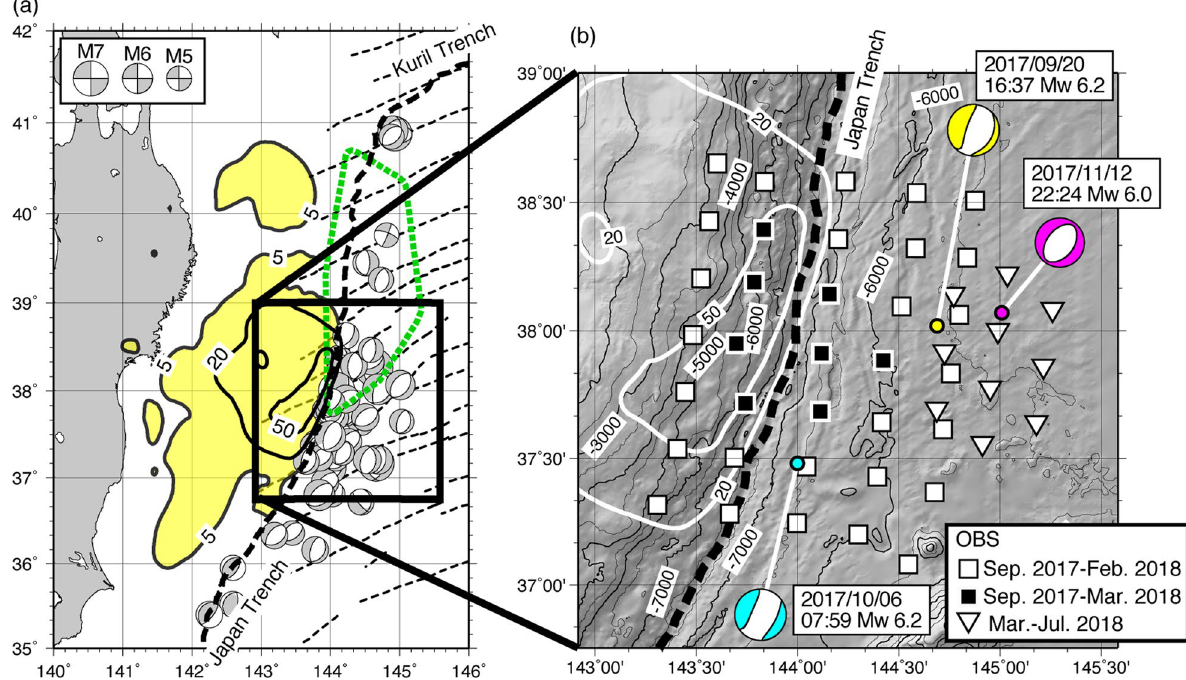
Fig. 1 Map of the survey area in the trench and outer trench slope of the central Japan Trench. a GCMT solutions (Dziewonski et al. 1981; Ekström et al. 2012) for Mw ≥ 5.0 earthquakes from March 11, 2011, to December 2021. Only GCMT solutions located on the seaward side of the trench axis are plotted. The yellow shaded region is the coseismic slip area of the 2011 Tohoku-oki earthquake with 5-, 20-, and 50-m contours (Iinuma et al. 2012). The thick black dashed line indicates the Japan and Kuril trench axes. Thin dashed lines are the magnetic anomaly lineations (Nakanishi 2011). The dashed green line indicates the 3-month outer-trench aftershock area of the 1933 Showa-Sanriku earthquake (Uchida et al. 2016). b Close-up view of the survey area. OBS locations are indicated with black and white squares and inverted triangles for different observation periods. Focal mechanisms of three M6-class earthquakes in 2017 taken from the GCMT catalog (Dziewonski et al. 1981; Ekström et al. 2012) are indicated. White contours indicate 20-m and 50-m contours of the coseismic slip distribution of the 2011 Tohoku-oki earthquake (Iinuma et al.